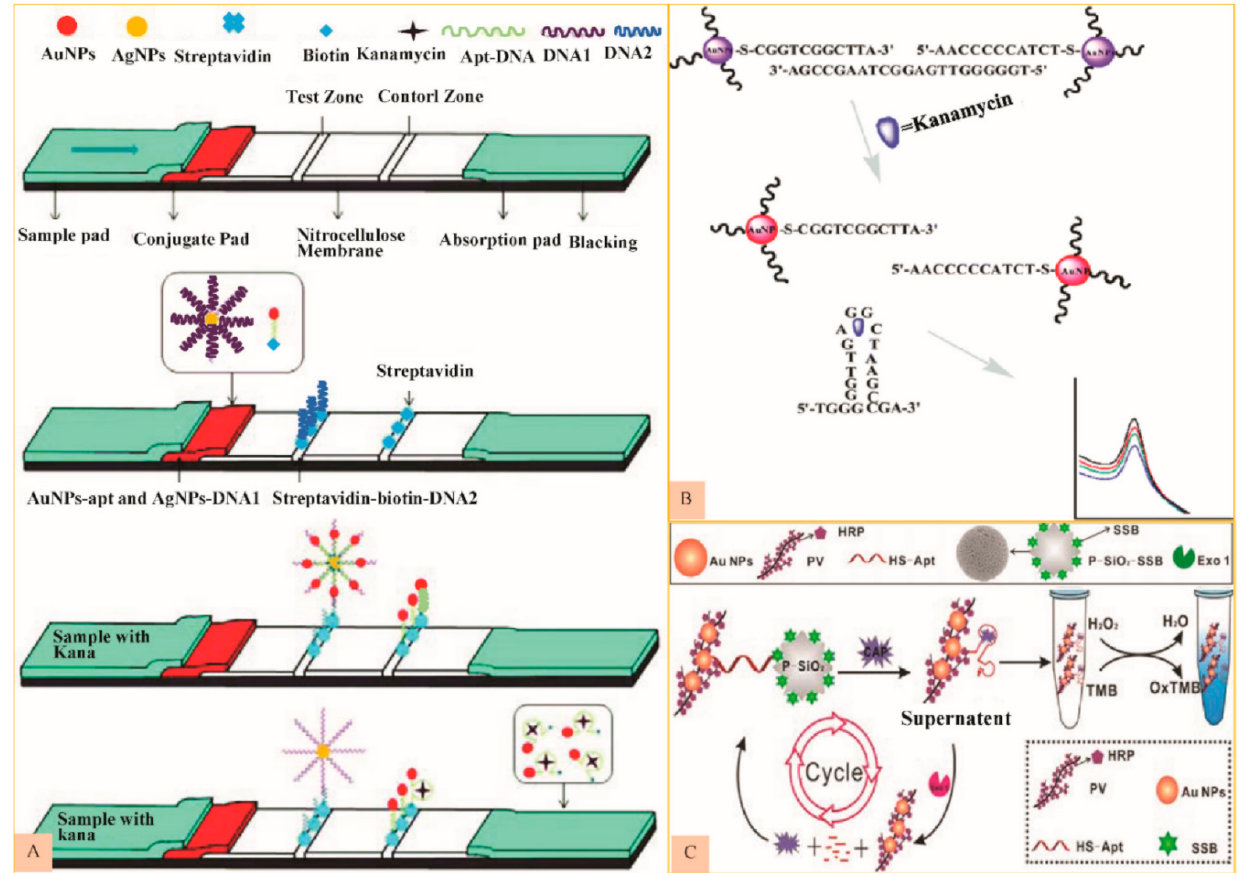
Figure 3. ( A ) Schematic figure showing system alignment and detection principle of strip aptasensor for KAN (Reproduced with permission from [65] © 2018 Royal Society of Chemistry). ( B ) Schematic diagram to represent spectrophotometric kanamycin detection (Reproduced with permission from [66] © 2014 Royal Society of Chemistry). ( C ) Scheme depicting the suggested biosensing of STR dependent on the developed colorimetric aptasensor (Reproduced with permission from [72] © 2017